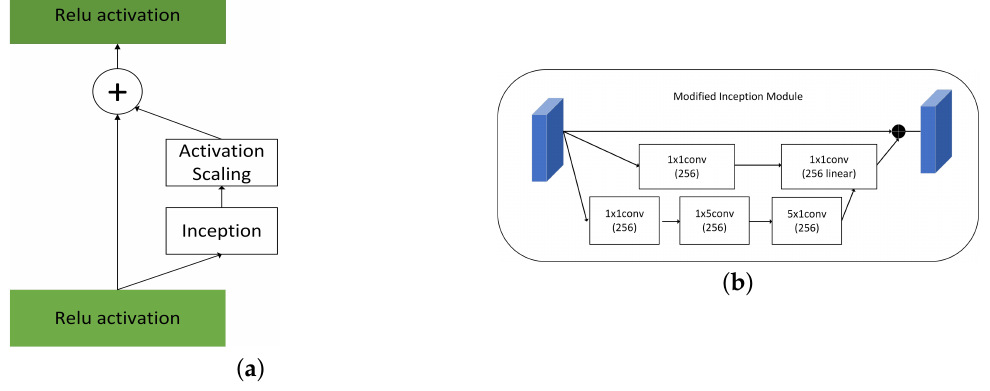
Figure 2. ( a ) Inception ( b ) Modified Inception